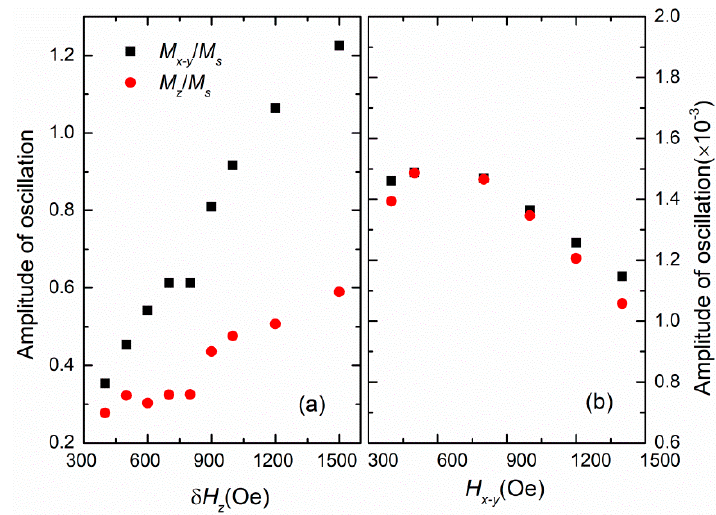
Figure 6. (Color online) Oscillation amplitude of magnetization precession as a function of modulated value of out-of-plane ( a ) and in-plane ( b ) magnetic anisotropy fields for the annealed and compressively strained (Ga, Mn)As thin film, obtained by LLG simulation.